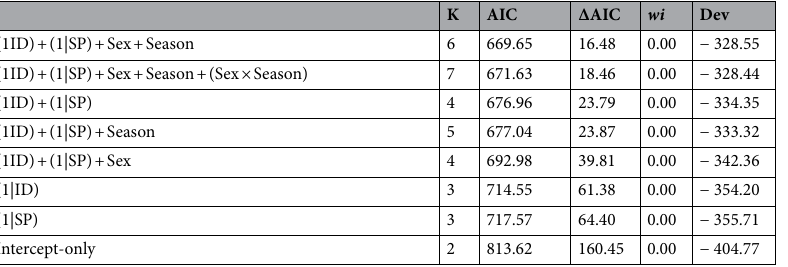
Table 3. Results of generalized mixed-effects linear-regression models evaluating variation in spatial overlap of wild pigs at Buck Island Ranch, FL. Spatial overlap was measured by utilization distribution of overlap index (UDOI, a and b) and degree (c and d). Random effects include the two individuals that are interacting (Dyad) or the individual (ID) and the year (Year) or the sampling period (e.g. Wet 2015, SP). Models include sex (Sex), level (home range-home range (HR-HR), home range–core area (HR–CA), and core area–core area (CA–CA) overlap, and season as fixed effects. For UDOI, sex indicates the sex of the two interacting individuals (two females, female and male, and two males). For degree, sex is the sex of the individual used to determine degree. Model output includes the number of parameters (K), AIC values, ΔAIC values, AIC weights (w i ), and residual deviance